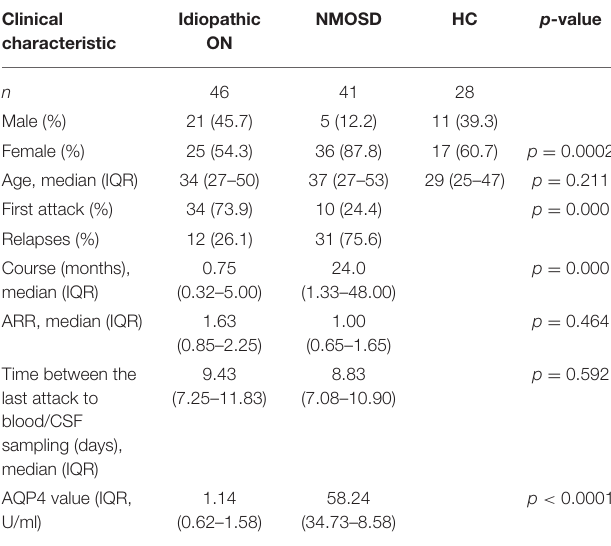
TABLE 1 | Demographic and clinical characteristics in idiopathic ON, NMOSD, and HC groups. Clinical